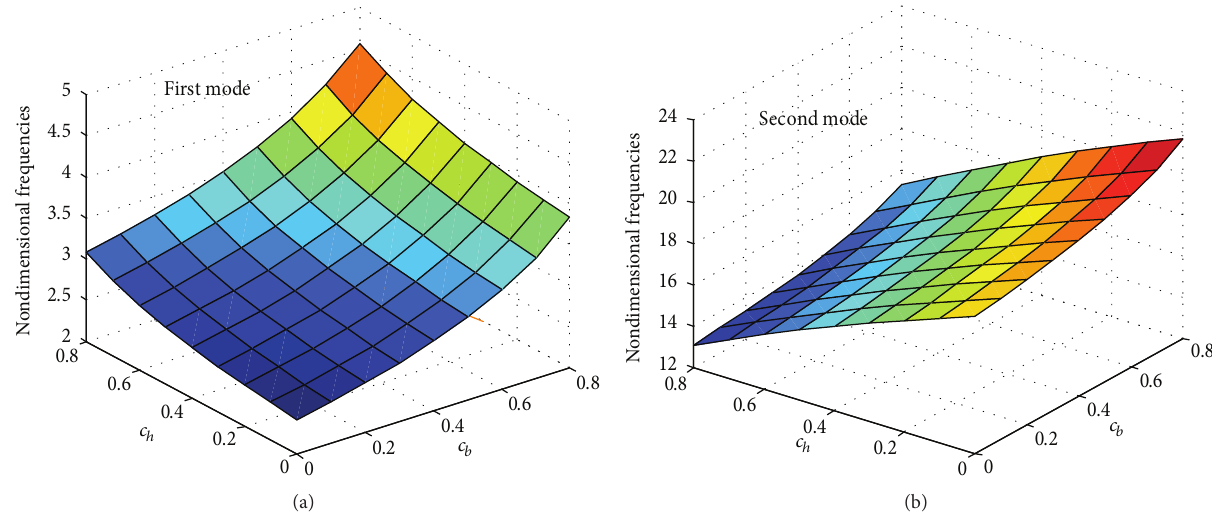
Figure 7: The variation of the first two nondimensional natural frequencies of axially FG beams with respect to taper ratios; boundary condition: C-F.